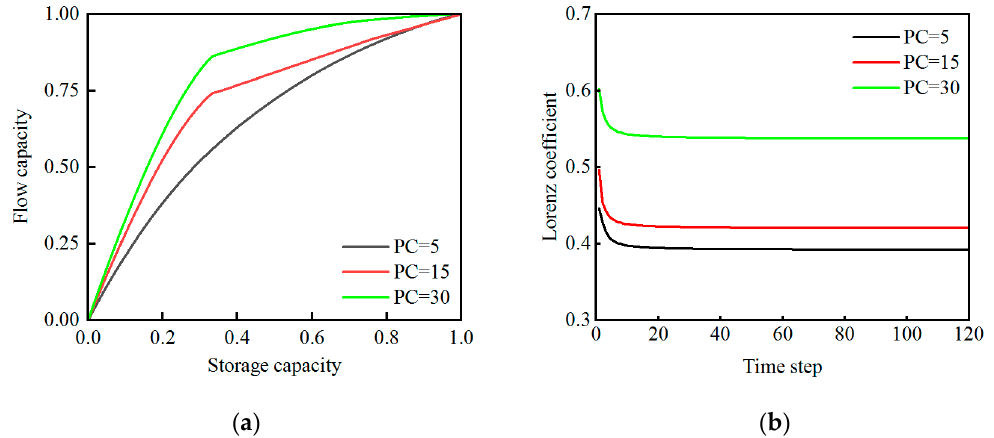
Figure 9. Flow heterogeneity evaluation of synthetic models with different vertical permeability contrasts. ( a ) Lorenz curve; ( b ) flow heterogeneity curve.